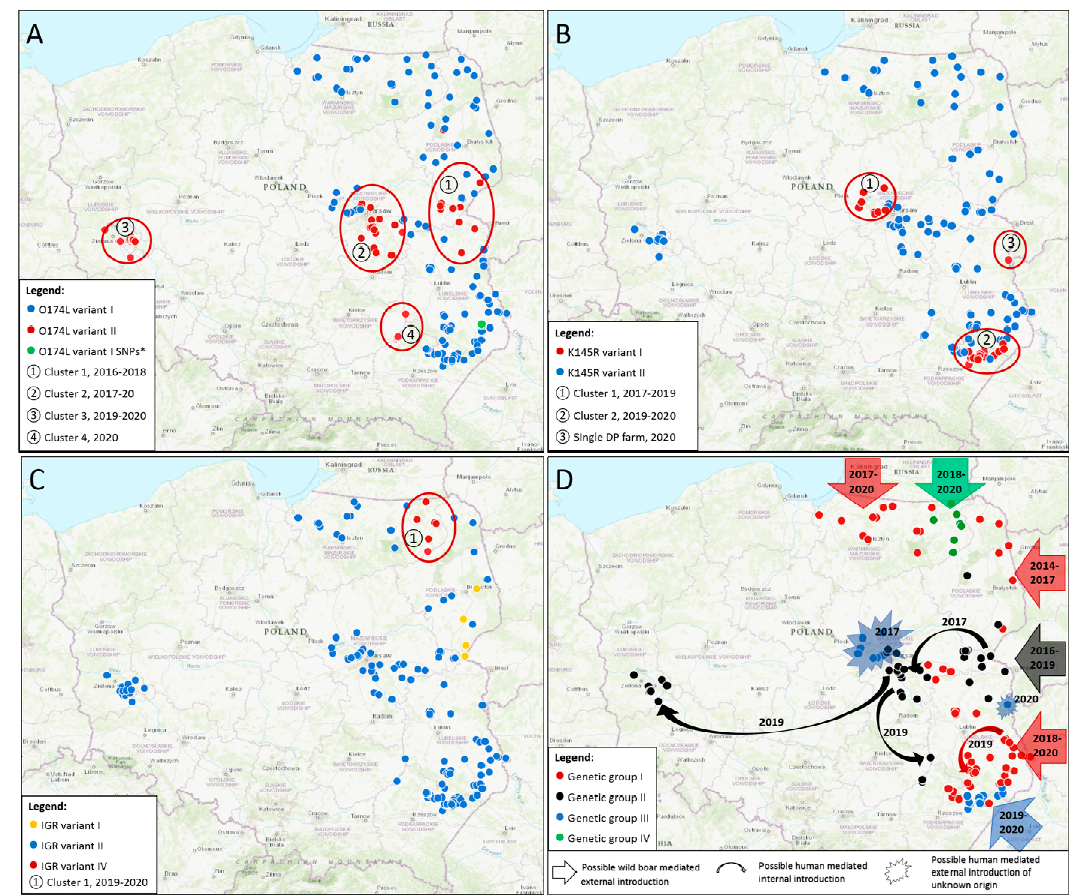
Figure 1. Spatial distribution of investigated gene variants of African swine fever virus (ASFV) in Poland during the period 2014–2020. Except for the data obtained during this study, the maps were supplemented with results from previous investigations [2,3,9] to improve the real picture of detected variations. ( A )— O174 gene. Blue dots ● represent variant I of the O174L gene, which shows 100% identity to the reference Georgia 2007/1 strain. Red dots ● represent variant II, containing a unique 14-nt insertion in this particular gene. O174L variant II formed four clusters ( ①②③④ ), separated in space and time. ( B )— K145R gene. Red dots ● represent variant I of the K145R gene, which shows 100% identity to the reference Georgia 2007/1 strain and other published sequences from Eurasia (except Polish and Ukrainian ones). Blue dots ● represent variant II with a SNP specific to Poland [2] and confirmed also in a single Ukrainian African swine fever (ASF) genomic sequence [9]. K145R variant I formed two distinct clusters ( ①② ), separated in space and time, moreover the single separated outbreak was confirmed in the eastern Poland ( ③ ). ( C )— IGR I73R/I329L region. Yellow dots ● represent variant I of the IGR region, which shows 100% identity to the reference